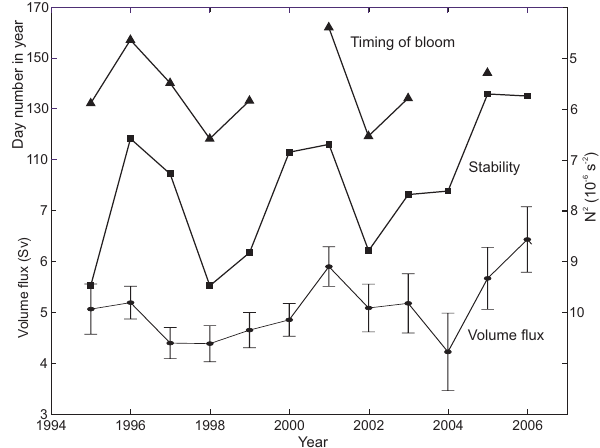
Fig. 10. Time series of NwAC in the Svinøy section, the averaged stability over the upper 200m for the Norwegian Sea N 2 = − g and the timing of phytoplankton bloom at Ocean Weather Station M (OWS-M, located at 66 ◦ N, 2 ◦ E, e.g., Østerhus and Gammelsrød, 1999). The volume flux data are averages over one year centred at 1 January the previous year compared to the other two time se- ries. The time series of the volume flux are moved for better visu- alization. The bars at the volume flux indicate standard error within each year. For the stability the Brunt V¨ais¨ala frequency ( N 2 ) is spa- tially averaged over areas occupied with AW in the Norwegian Sea between 64–72 ◦ N and 2 ◦ W–16 ◦ E during May. Note that the y- axis for stability (right axis) is reversed. The stability data are from Melle et al. (2010) while the timing of bloom data from OWS-M are from Rey